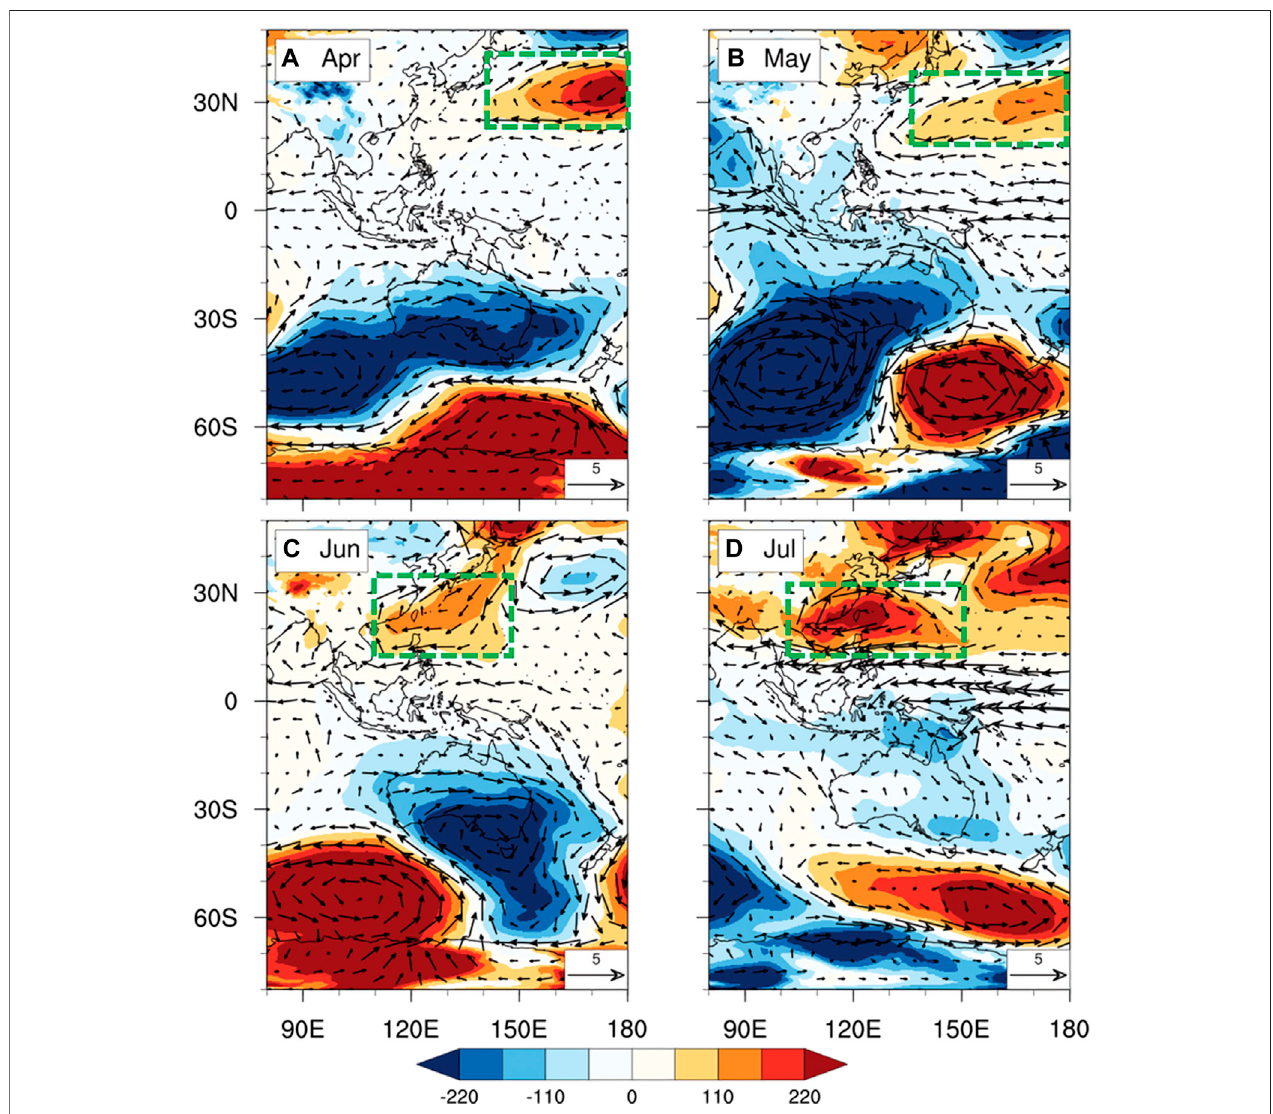
FIGURE 9 | Composite differences of (A) April, (B) May, (C) June, and (D) July mean SLP (shading; unit: Pa) and 850-hPa wind anomalies (vector; unit: m s − 1 ) between the extreme high and low years of SST SWA,34 . Green dash rectangles in (A – D) indicate the seasonal shift of anomalous westward or southwestward shift of subtropical high that highly associates with the negative phase of